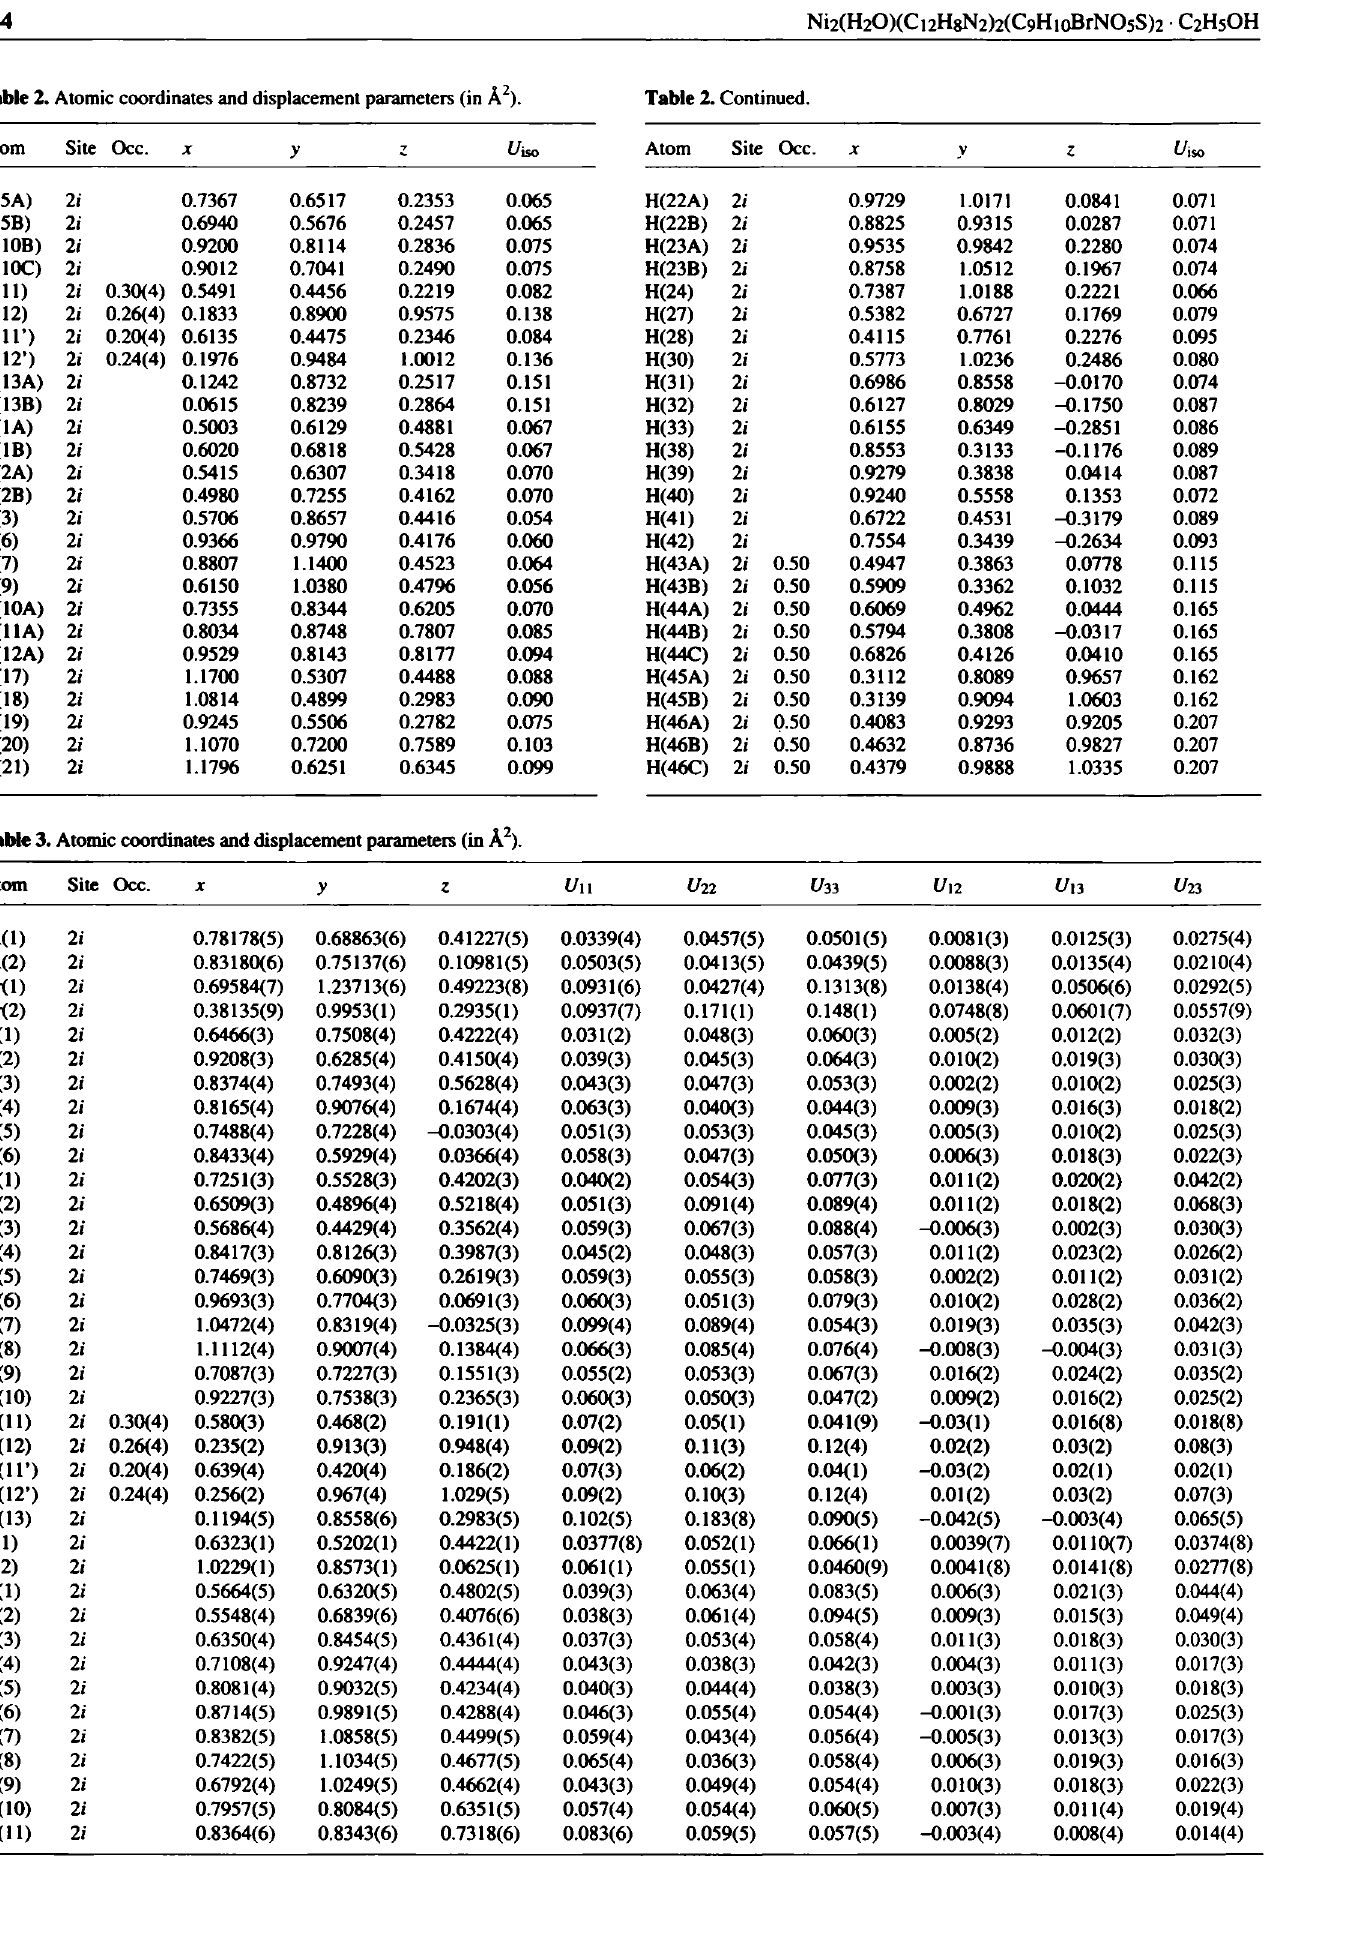
Table 2. Atomic coordinates and displacement parameters (in Â 2 ).